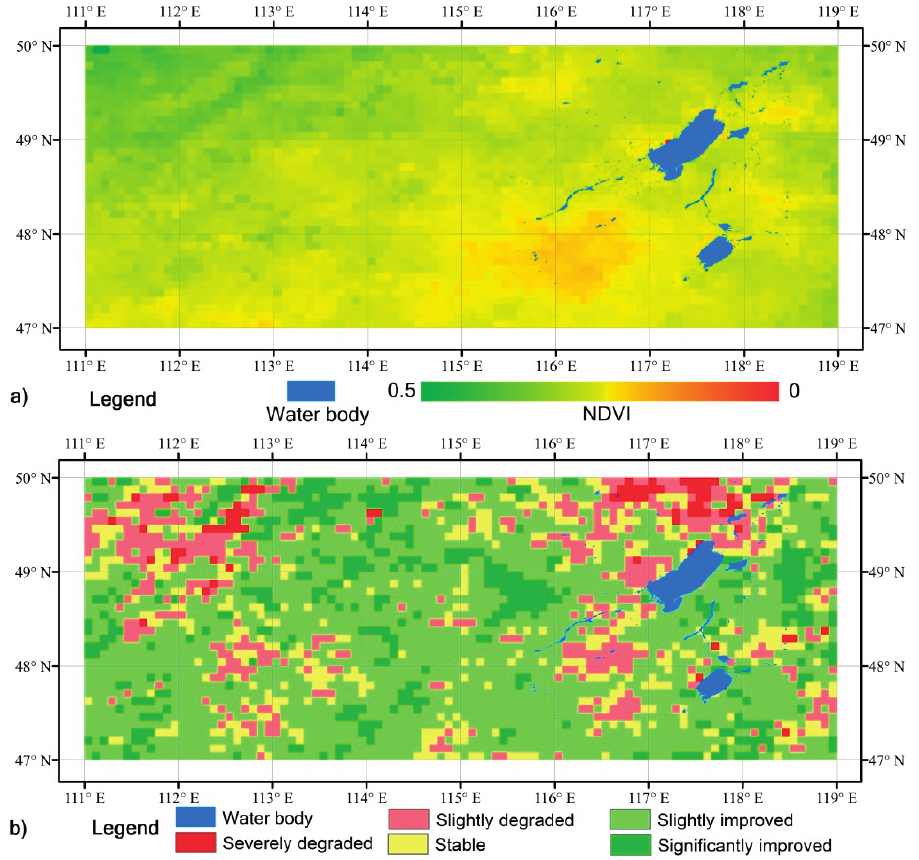
Figure 8. Spatial distribution of ( a ) average NDVI and ( b ) trends of inter-annual NDVI change over 2002 to